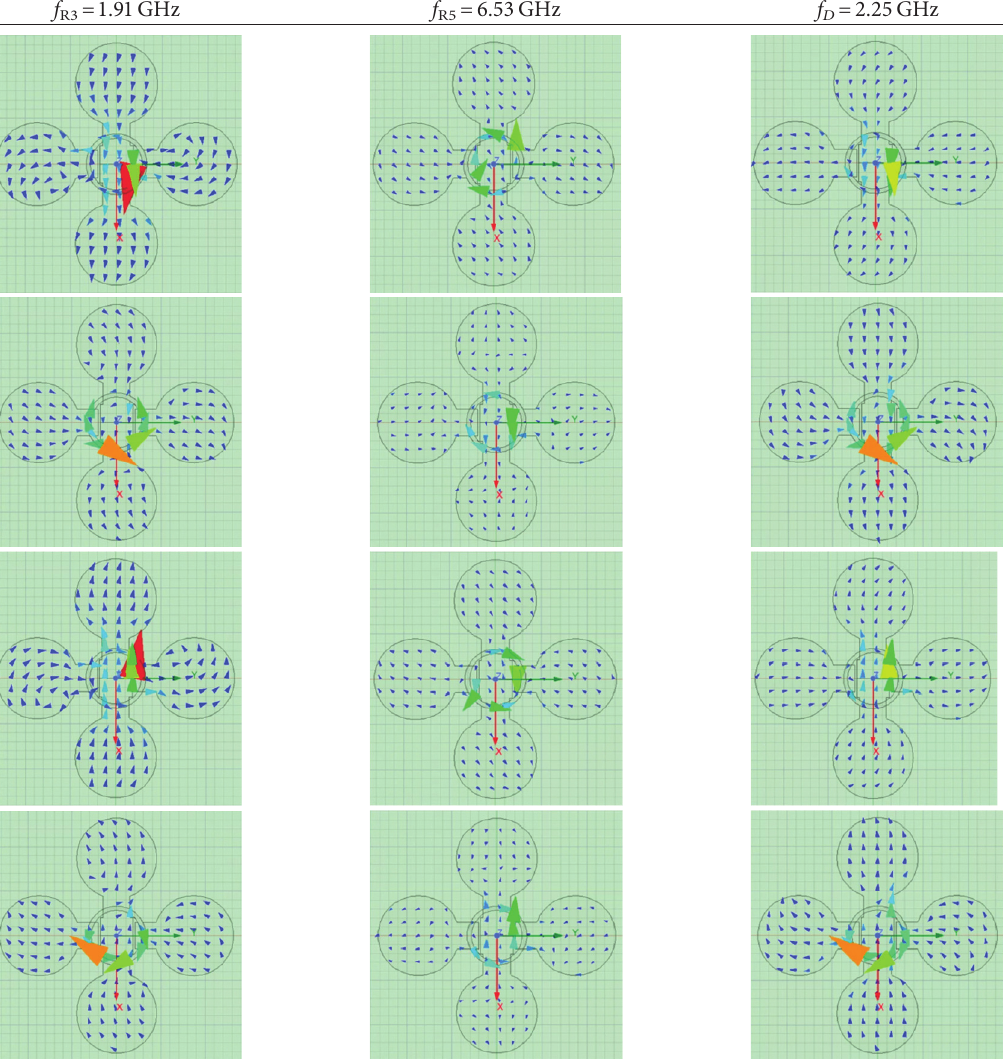
Table 6: Surface electric current distributions at different instants of time for resonance frequencies f well as for the design frequency f D � 2.25 GHz.